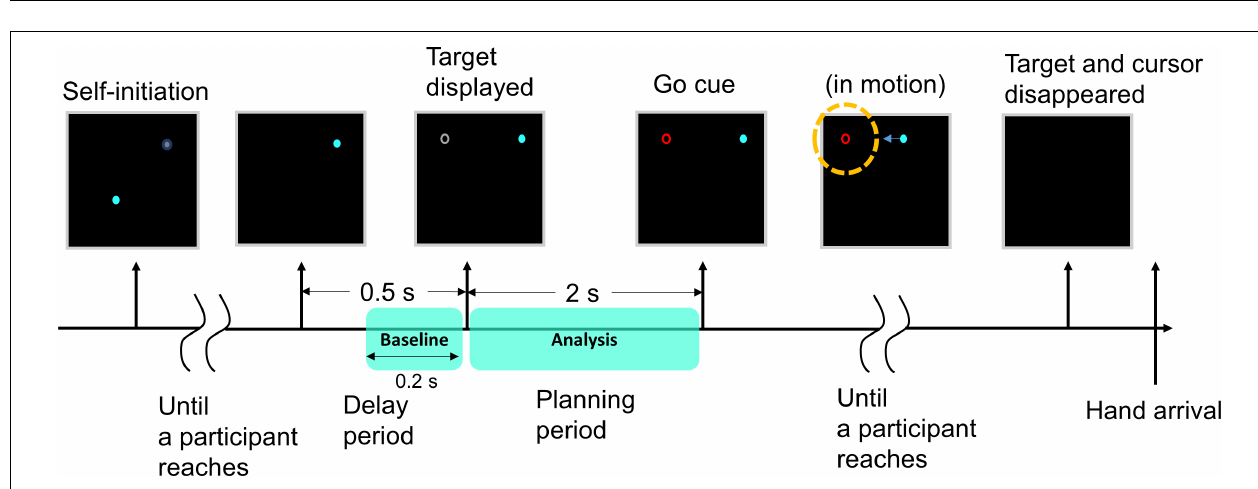
FIGURE 2 | Images on the screen during a trial. At the start of the trial, an initial position indicator (a gray blurred circle) appeared at one of the six positions so that the participant moved the cursor (a blue circle) to the initial position by moving his/her hand. When the cursor reached the initial position, the indicator disappeared. After 0.5 s, a gray target appeared at one of the remaining five positions. The participant was instructed to prepare for movement execution for 2 s (planning period, premovement). When the color of the target changed to red, the participant moved his/her hand to move the cursor to the target (execution). Before the cursor completely reached the target (a yellow dotted circle in the figure), both the cursor and the target disappeared. The target and the initial cursor position were placed at one of six locations, respectively. This procedure was repeated for each